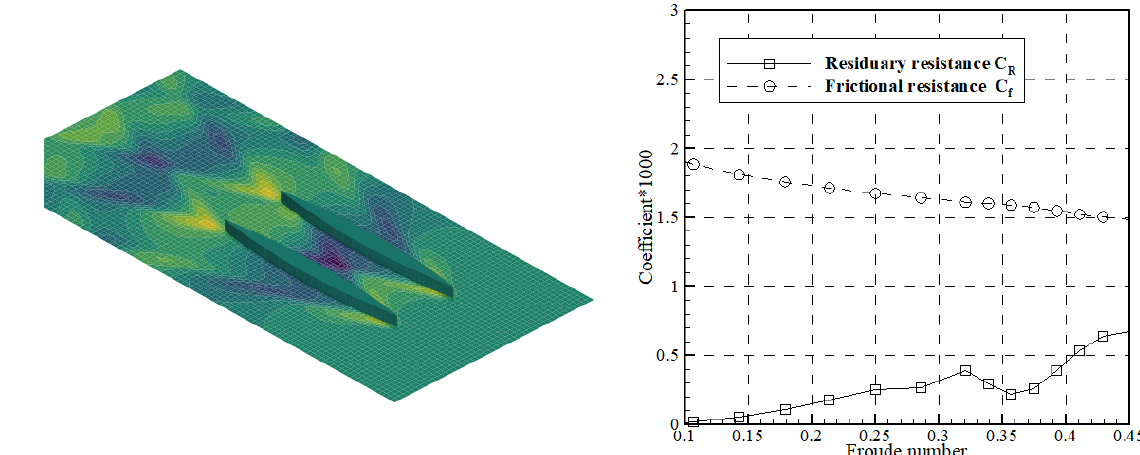
Figure 12. Picture of the hull shape considered in this study and related hydrodynamic